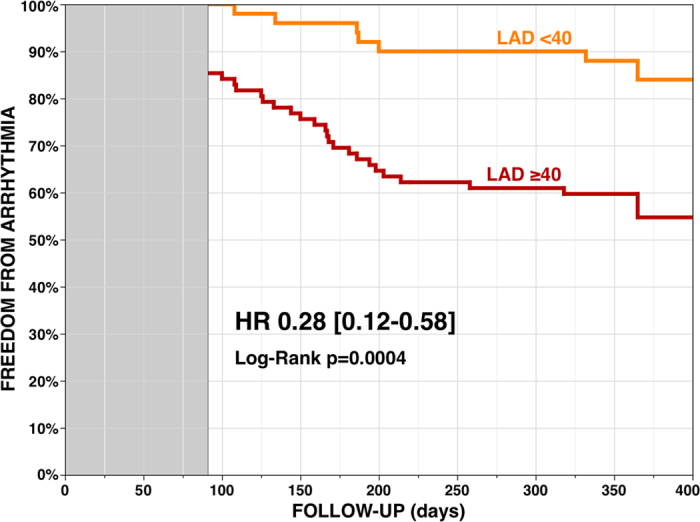
Arrhythmia-free survival without anti-arrhythmic drug after a single ablation procedure according to left atrial diameter, <40 (N = 62, 39%) or ≥40 millimeters (3-month blanking period).